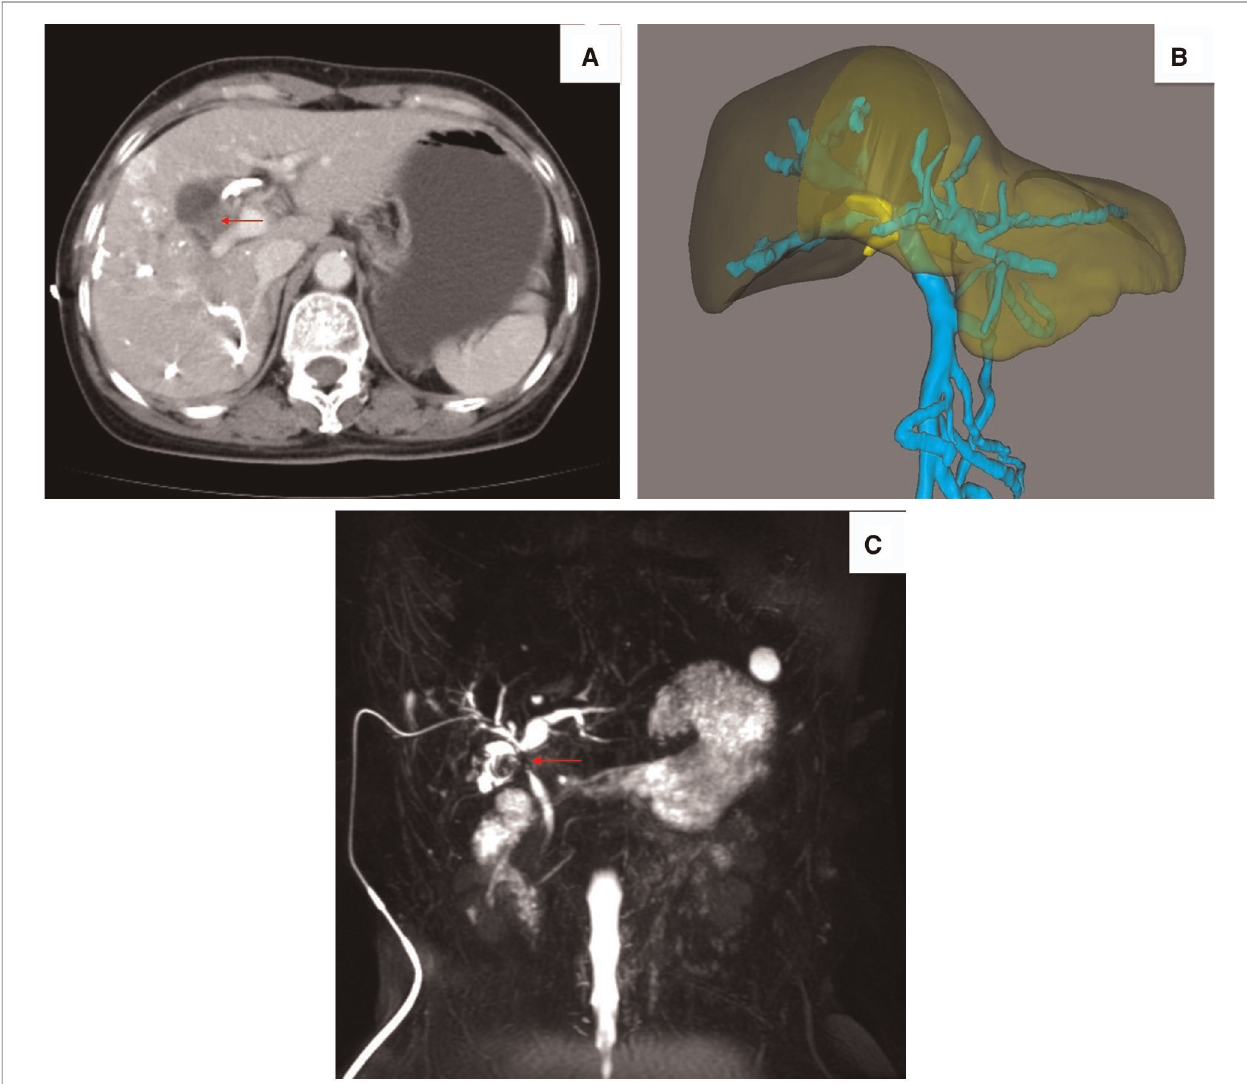
FIGURE 2 | ( A ) Abdominal CT 1 month later revealing an improvement in hepatic duct dilation (the red arrow designates the tumor). ( B ) Residual liver volume (RLV) increased up to 55.57%. ( C ) MRCP indicating a space-occupying lesion (red arrow) at the porta hepatitis, involving the cystic